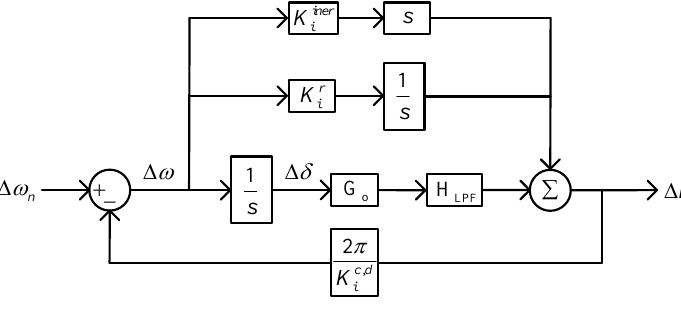
Figure 5. Small signal model of the proposed control